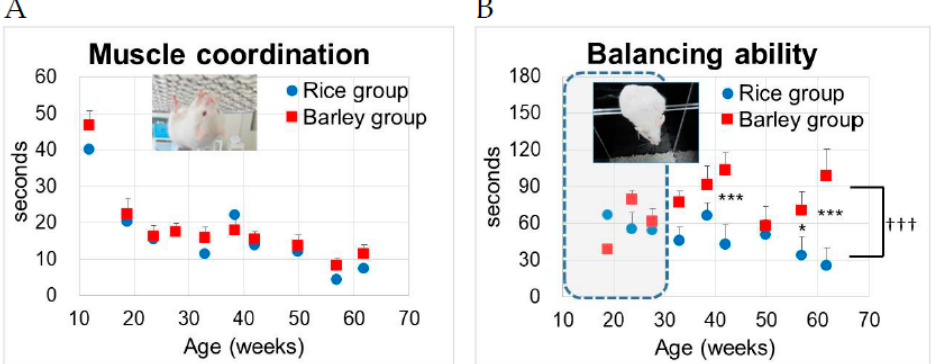
Figure 6. Changes in muscle coordination and endurance balancing in SAMP8 mice consuming rice or barley diets during the lifespan: ( A ) wire hanging test; ( B ) balancing on an acryl rod. By two-way ANOVA, ††† p < 0.001; -group, *** p < 0.001, *p < 0.05 by Bonferroni’s post-hoc test for multiple comparisons.